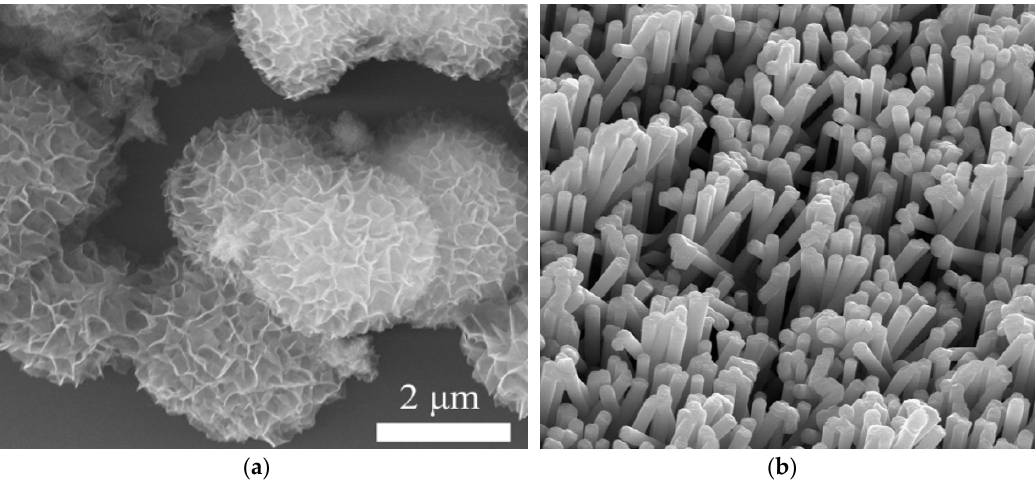
Figure 4. SEM image of NiAl-LDHs ( a ) [23] and Ni nanowire array electrode ( b ) [28]. Reproduced with permission from [23] and [28] copyright 2016, 2013